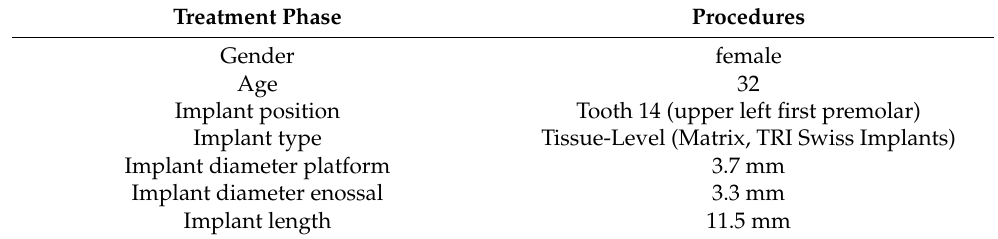
Table 1. Patient information.